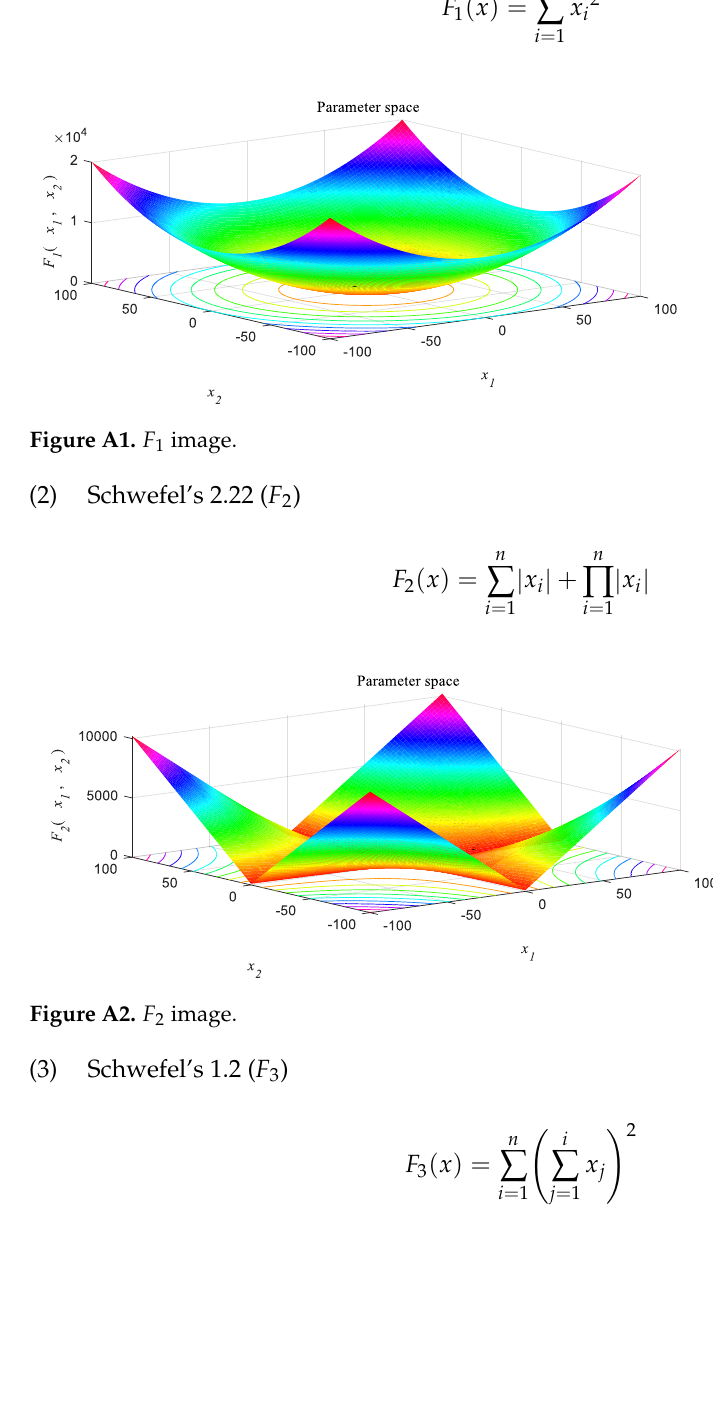
Figure A2. F 2 image.